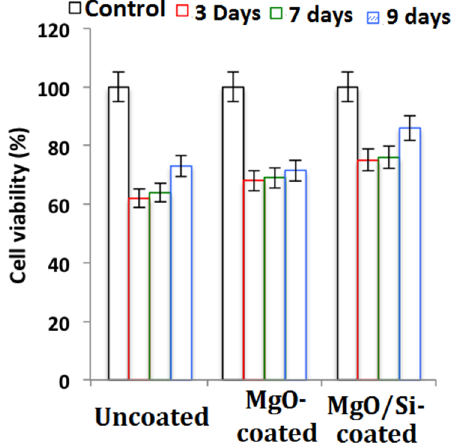
Figure 15. Normal human osteoblast (NHOst) viability cells results indicated by MTT assay after indirect treatment with uncoated, MgO ‐ coated and Si/MgO ‐ coated after 3, 7, and 9 days.